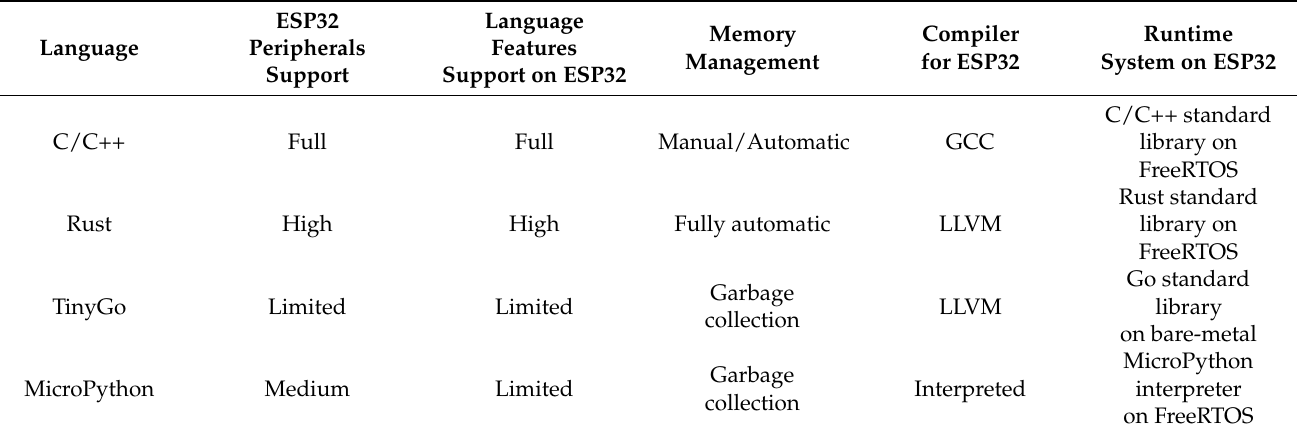
Table 1. Overview of the programming languages compared on